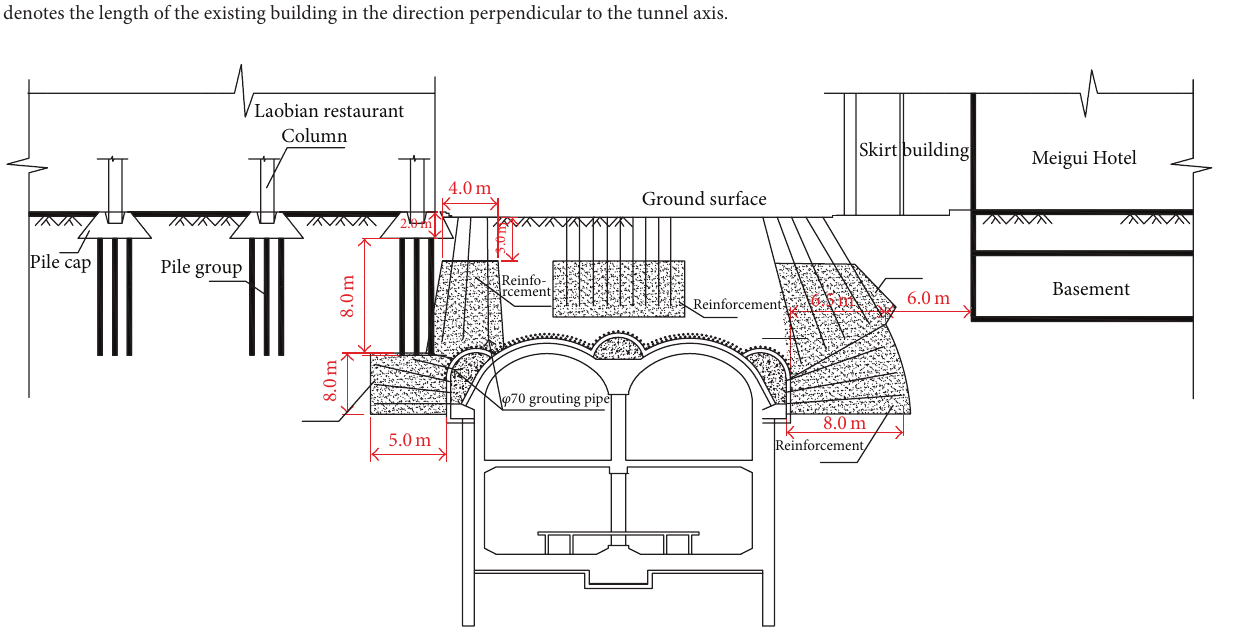
Figure 13: Sleeve-valve-pipe grouting